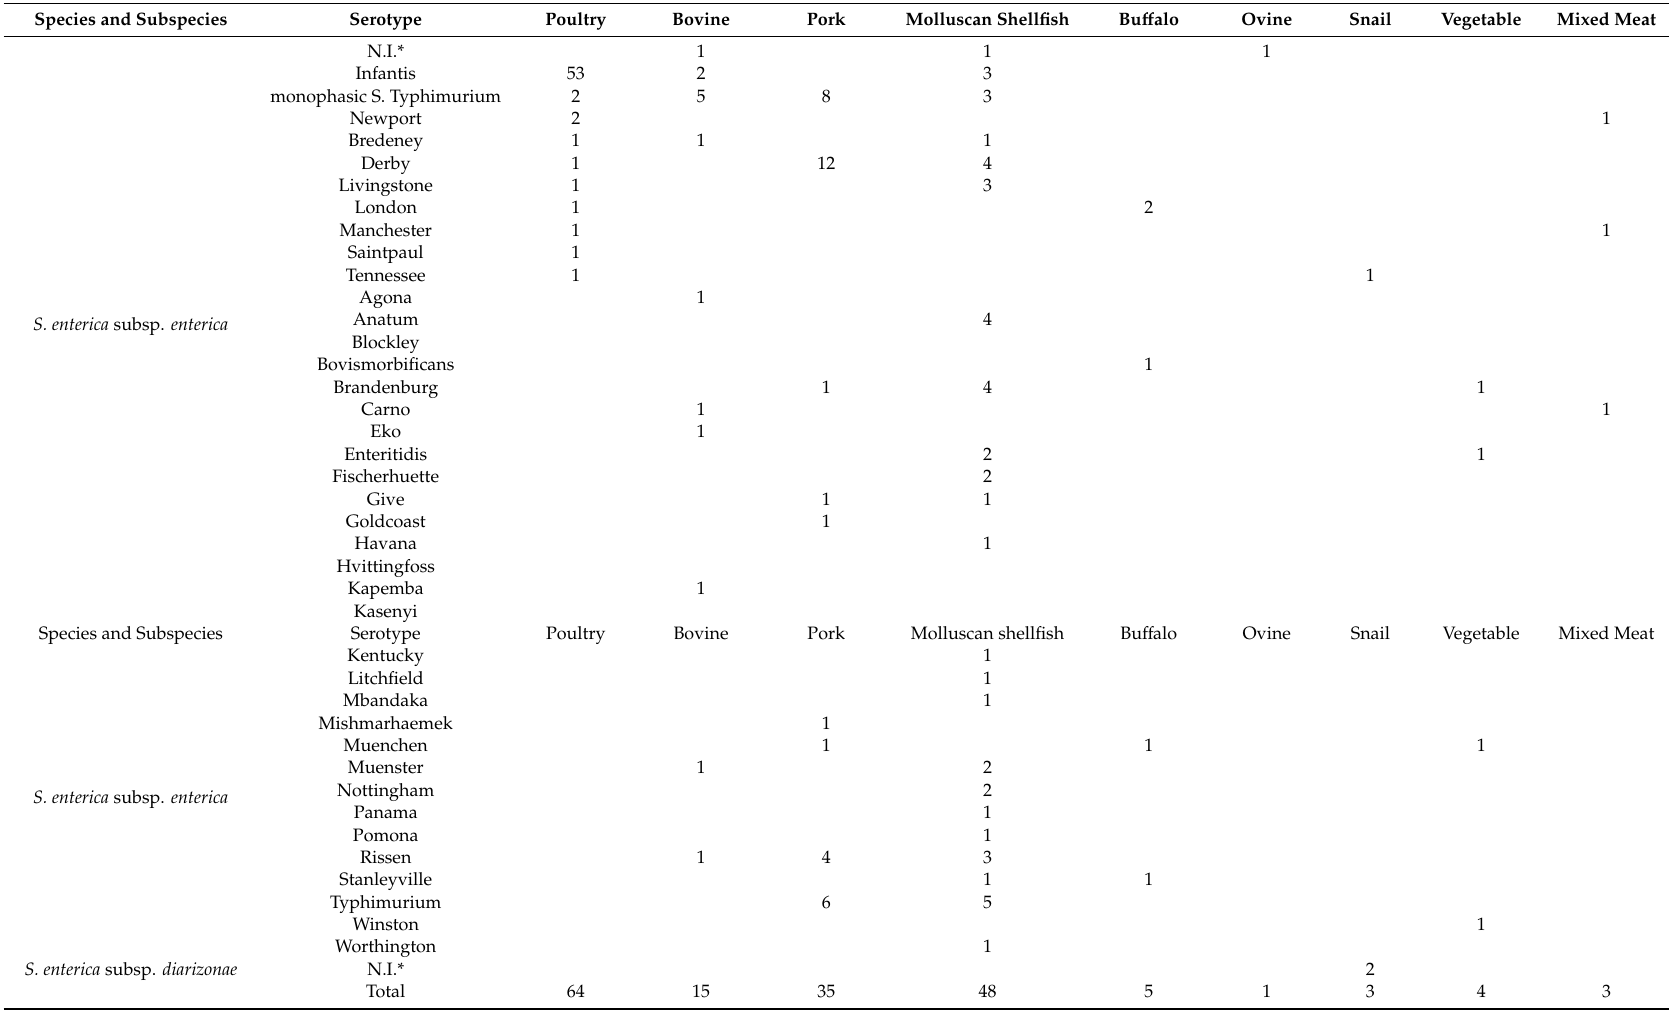
Table 3. Number of serovars used for the evaluation of the antimicrobial resistance grouped by source. The asterisk (*) indicates not identified